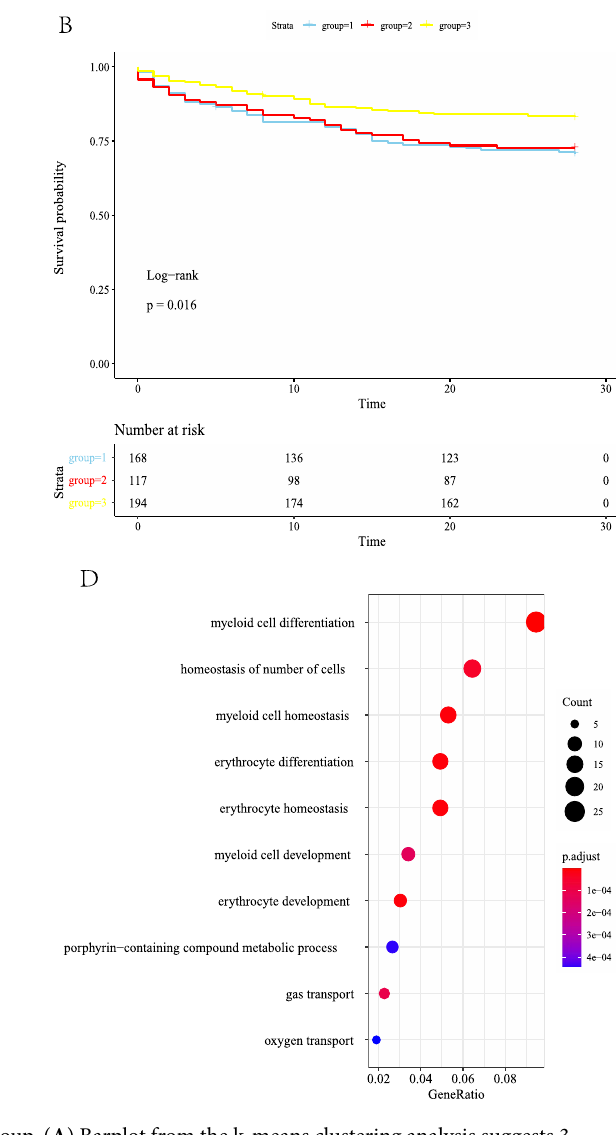
Figure 3. Clustering analysis of sepsis group. ( A ) Barplot from the k-means clustering analysis suggests 3 clusters would be the best classification choice. ( B ) Kaplan–Meier survival analysis showed the mortality of group 3 is significantly higher than that of group 1 and group 2. ( C ) GO annotation of DEGs between group 1 and group 3. ( D ) GO annotation of DEGs between group 2 and group